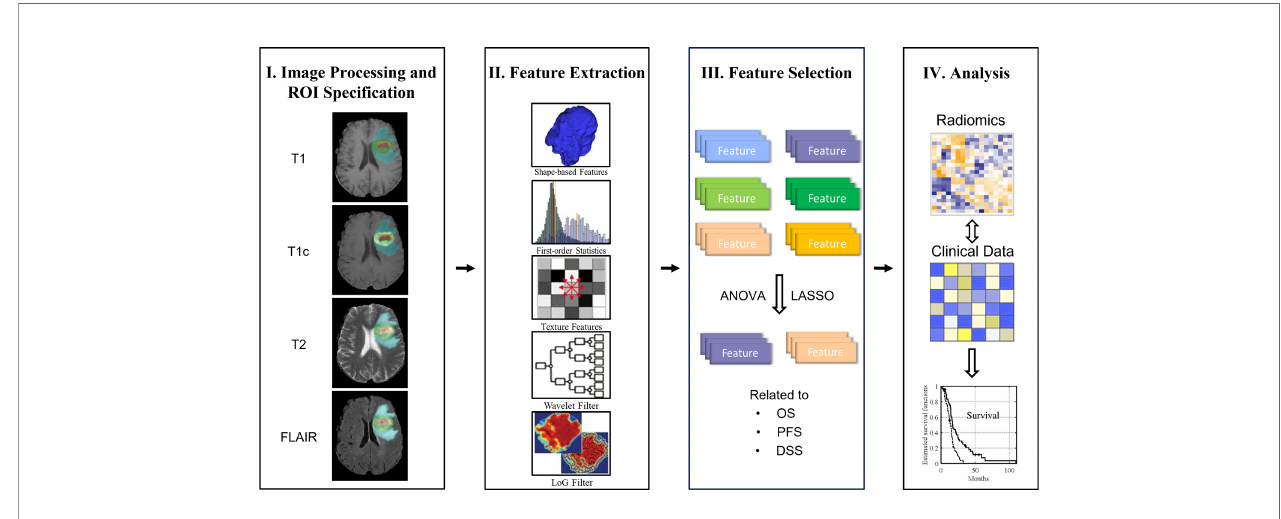
FIGURE 1 | Overall work fl ow of the study.